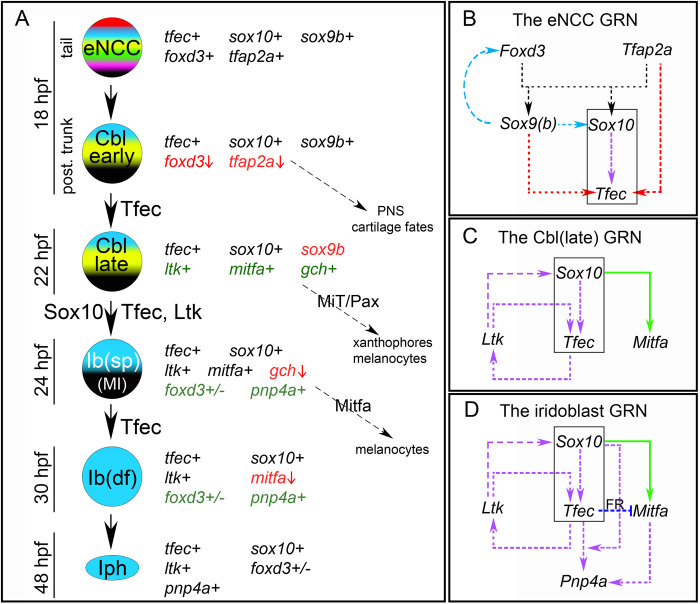
tfec is broadly expressed during progressive fate restriction of the iridophore lineage from eNCCs, and is required to specify definitive iridoblast, Ib(df), from the melano-iridoblast, Ib(sp).(A) Schematic representation of partially restricted iridophore progenitors during development, along with the expression characteristics and potential fate choices of each ([14], this work). tfec is initially co-expressed with eNCC specification factors, which gradually become downregulated (red font, vertical red arrow), while lineage-specific factors become upregulated (green font). Proteins indicated on the black arrows are considered important for the respective fate restriction step. (B) The position of tfec in the GRN guiding vertebrate NCC induction. Dashed arrows indicate interactions which could be either direct or indirect. In multipotent NCCs, Tfap2a and Foxd3 redundantly activate tfec expression (red arrows; this work), which is later maintained in the iridophore lineage by Sox10 (purple arrow; [14]). This activation occurs independently of previously described co-regulation of zebrafish sox9b and sox10 expression by Tfap2a and Foxd3 (black arrows; [49]), and is unaffected by potentially conserved activation of sox10 and foxd3 by Sox9b (blue arrows, as shown in chick; [50, 51]). (C) Following transition of Cbl early to Cbl late, tfec expression is supported by positive feedback interactions between Sox10, Ltk and Tfec, as described in Petratou et al., 2018 [14]. Sox10 directly activates mitfa expression (solid green arrow; [25]), which during early Cbl specification is co-expressed with tfec [14], inhibiting its expression to bias progenitors towards the melanocyte fate. (D) As the lineage progresses past the Cbl, into the Ib(sp), Ib(df) and mature iridophore stages, factor R (FR) mediates Tfec-dependent downregulation of Mitfa (dark blue edge), and expression of the marker pnp4a becomes prominent [14]. In (B-D) the black box outlines the core connecting the three networks. MiT, microphthalmia family transcription factors; PNS, peripheral nervous system.